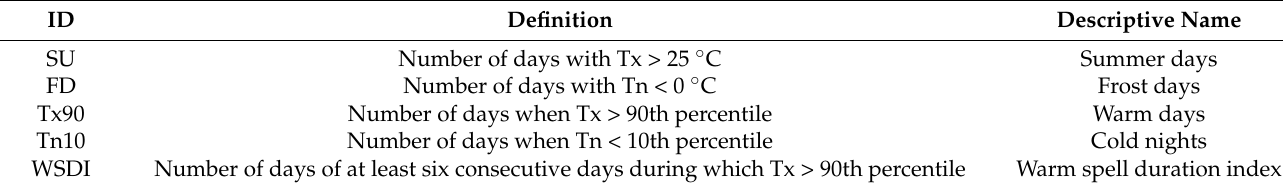
Table 2. Acronym (ID), definition, and descriptive name of the temperature indices based on daily maximum (Tx) and minimum (Tn) temperatures calculated on the seasonal